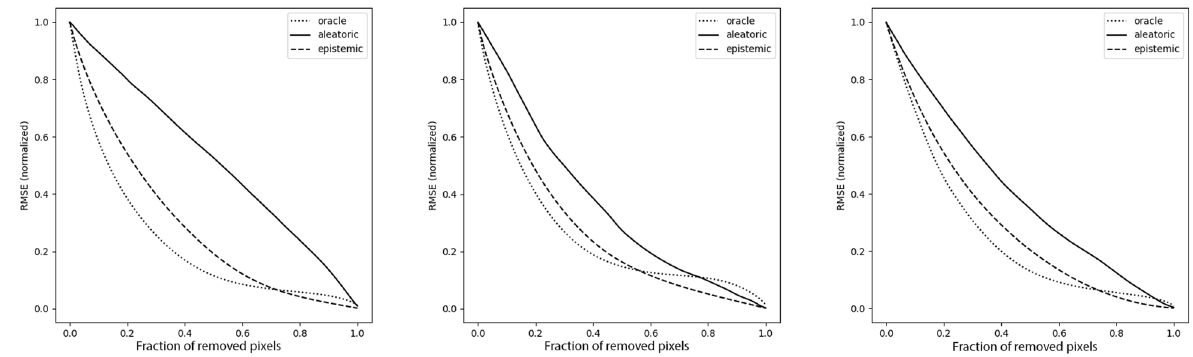
Fig. 17 Sparsity curves for the novel dataset. Left: variational; middle: Monte-Carlo dropout; right: